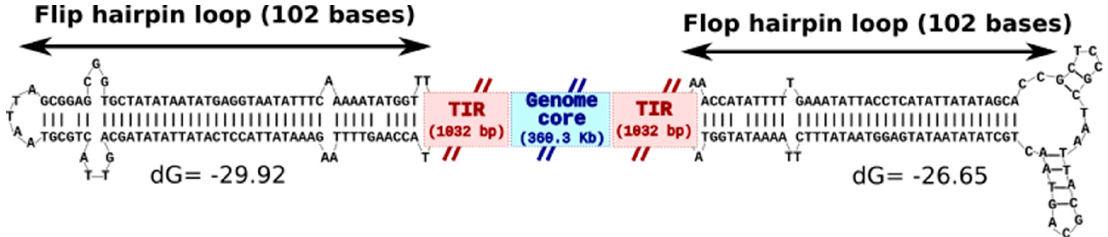
Figure 2. Sequence structures at the ends of the KV-LCC10 chromosome. Schematic representation of the linear KV-LCC10 genome with covalently closed, incompletely base-paired hairpin termini flanked by TIRs. The 102 bp hairpin sequences and TIRs on each side of the genome are inverted and complementary. The minimum free energy (dG) fold of the two versions of the hairpin loop (flip/flop) was inferred using the MFOLD program. Please note that the positioning of the flip/flop versions relative to the left/right sides of the genome could not be determined using the current data and is therefore represented here arbitrarily.